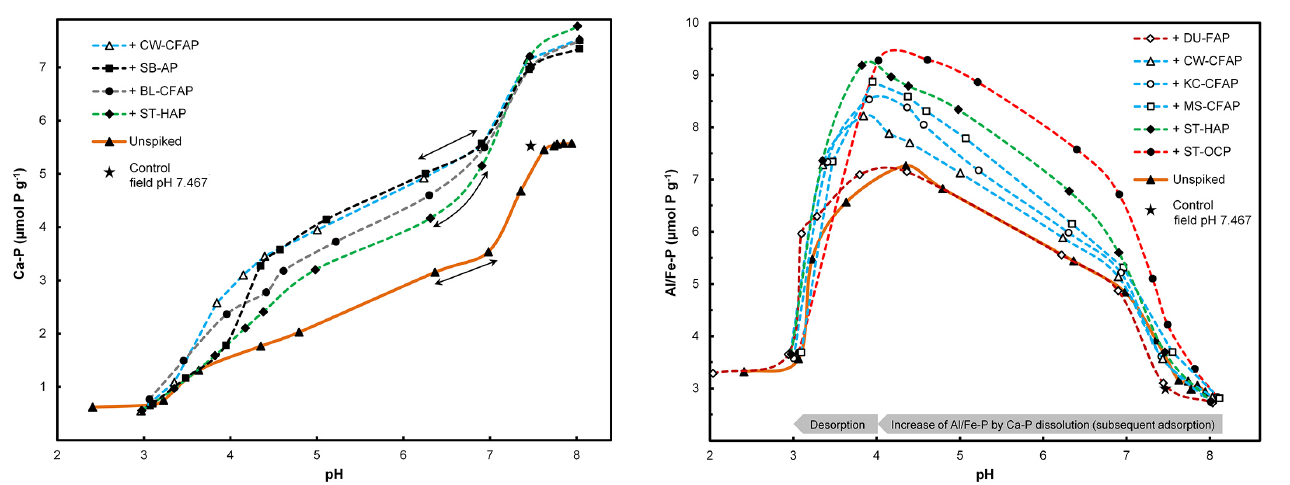
Figure 6. Differential Ca-P dissolution in sediment at varying pH as determined by subsample incubation of sediment (unspiked and with reference mineral additions) and subsequent fractionation (CONVEX method). Cryptocrystalline collophane (BL-CFAP) dis- solved similar to HAP (ST-HAP) in the range 6.3–6.9 (see increased slope, arrows). Analysis was performed using sediment from the Firth of Thames, New Zealand. Control: fractionation without prior incubation. See Table 1 for origins of added standard materials.